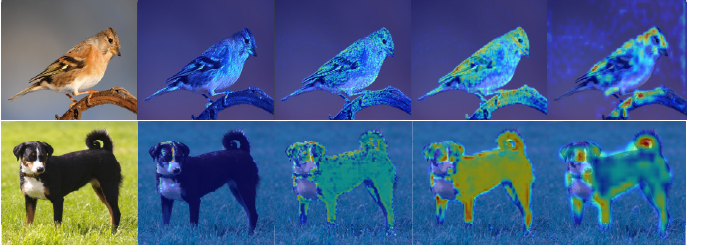
Figure 1. Comparison of heat maps for different stage features. The feature maps of the input images at each stage of the network are visualized, and the responses of neurons at different stages to different features are compared.